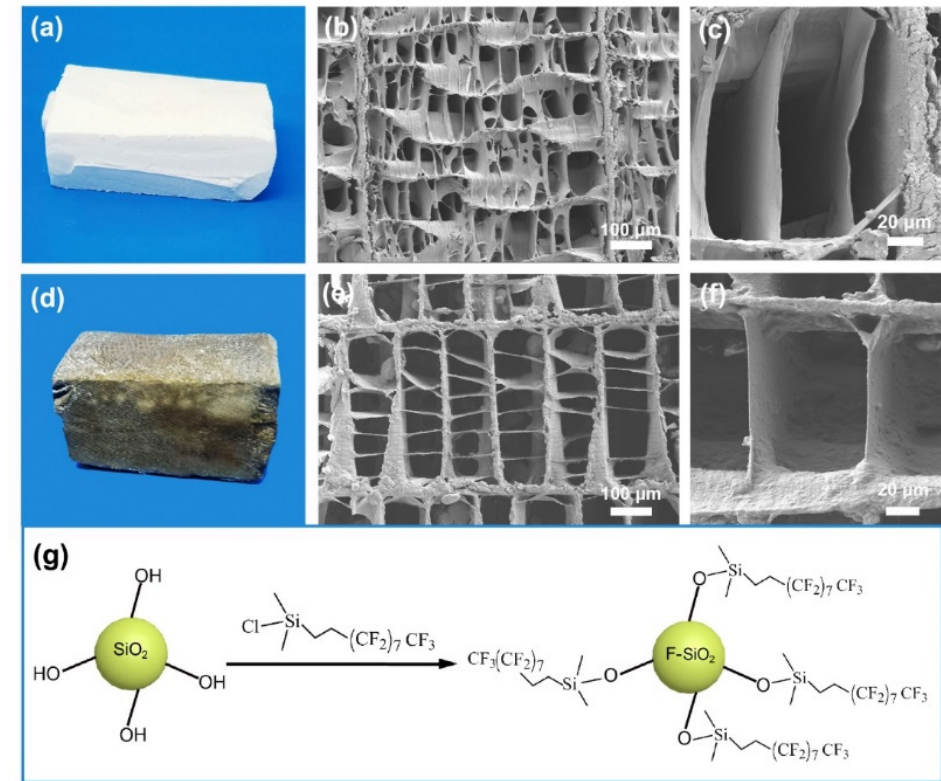
Figure 3. ( a ) Photograph of an untreated cuttlebone sample, ( b ) low-magnification SEM image of the cross-section of an untreated cuttlebone sample, ( c ) high-magnification SEM image of the lamel- lar structure of an untreated cuttlebone sample, ( d ) photograph of a superhydrophobic cuttlebone sample, ( e ) low-magnification SEM image of the cross-section of a superhydrophobic cuttlebone sample, ( f ) high-magnification SEM image of the lamellar structure of a superhydrophobic cuttle- bone sample, ( g ) the reaction scheme of preparing fluorinated silica